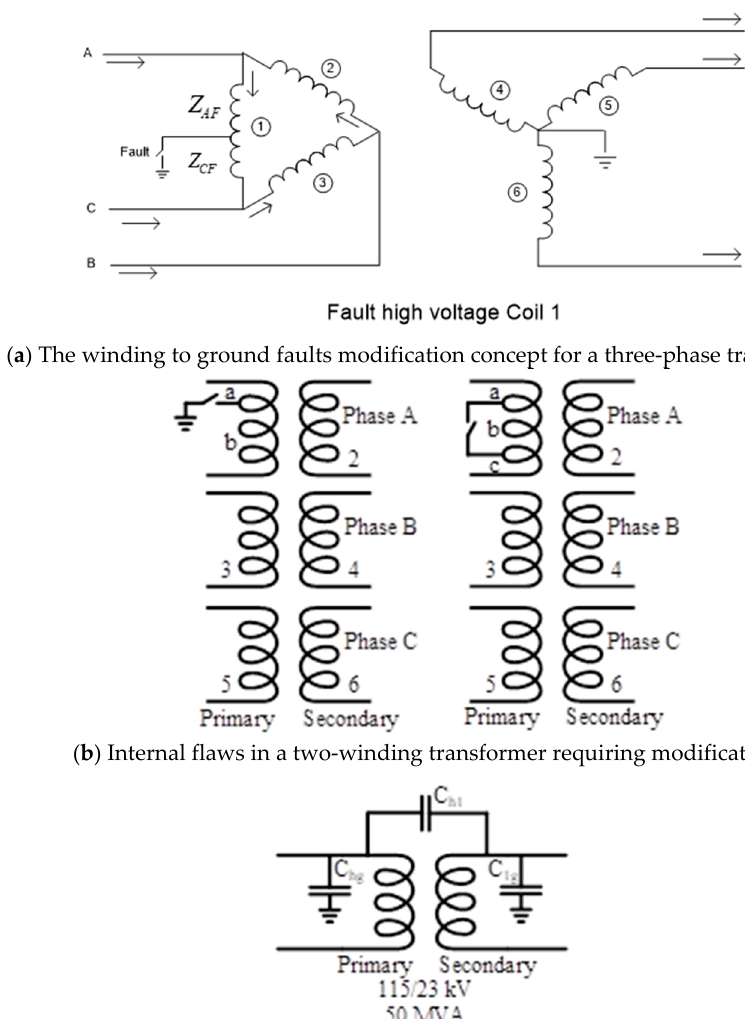
Figure 2. Diagram of the suggested fault-classification algorithm in simplified form.